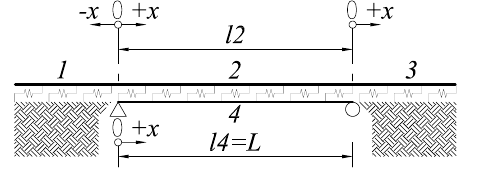
Figure 1. A simple girder with a fixed bearing on one side of the